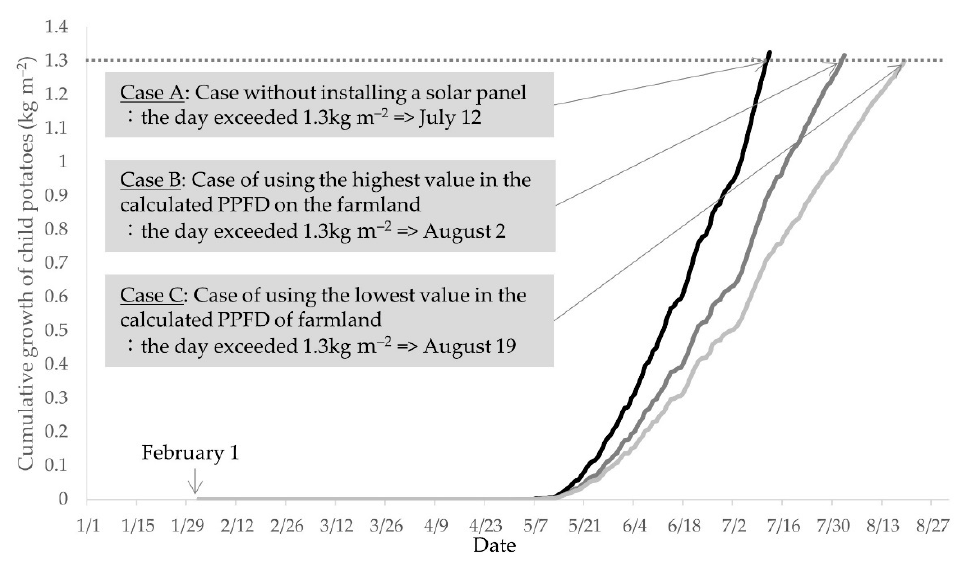
Figure 8. Impact of solar panel installation on taro shipping dates.